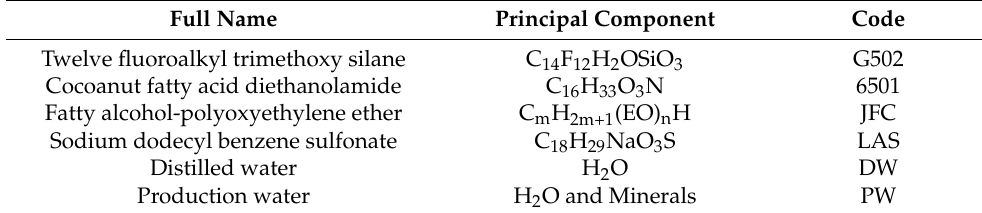
Table 1. Category of surfactants selected in the test of contact angle.